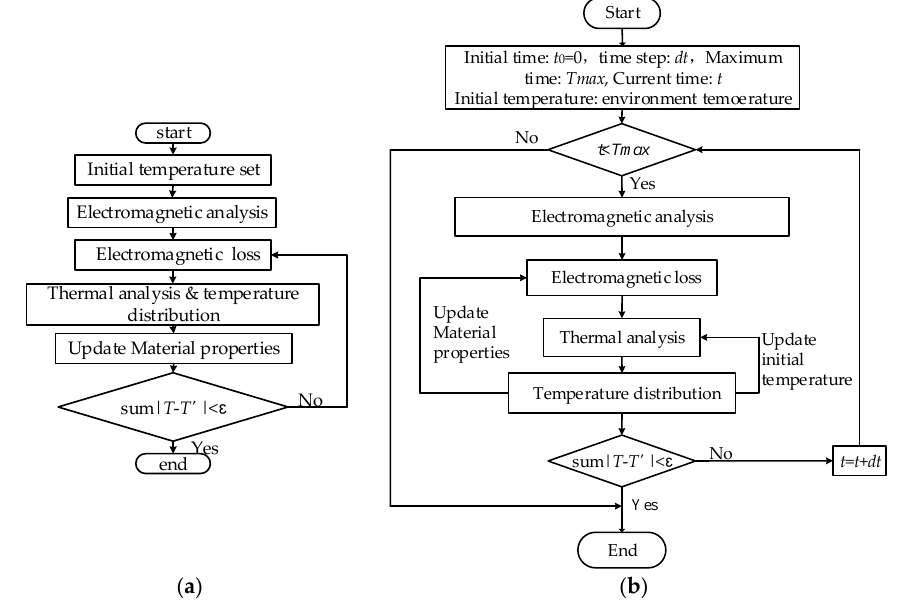
Figure 13. Bidirectional coupling of EM field and TH field. ( a ) Steady state TH analysis. ( b ) Transient state TH analysis.